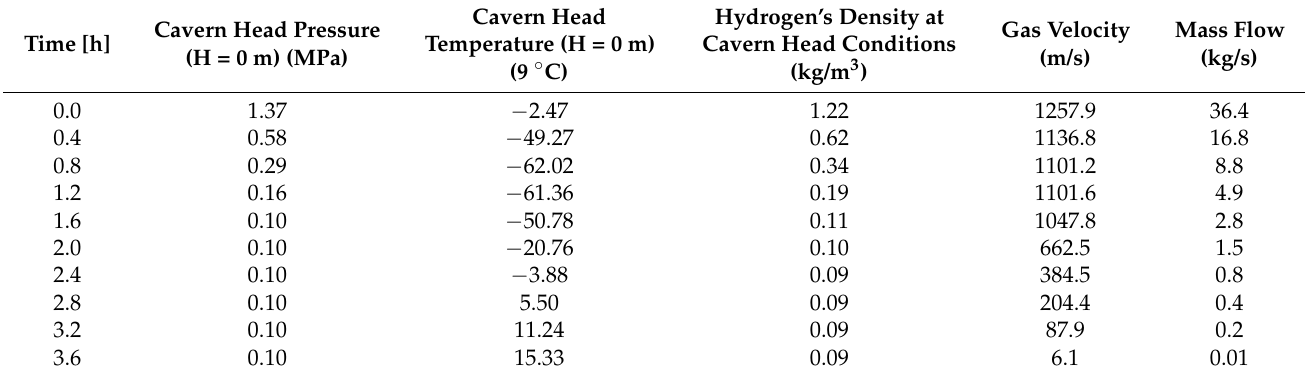
Table 7. Characteristics of the source term generated by a gas leak in the scenario EZ5310.